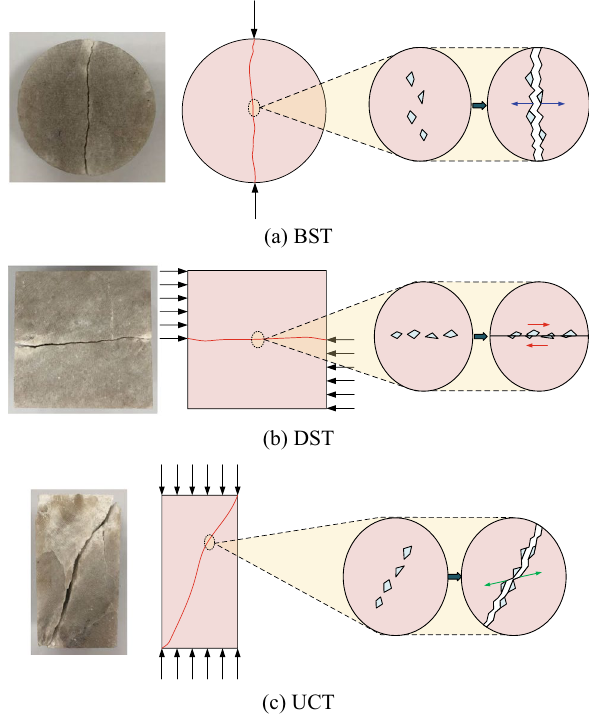
Fig. 12 Macroscopic failure mode of rocks in each type of test: a BST; b DST; c